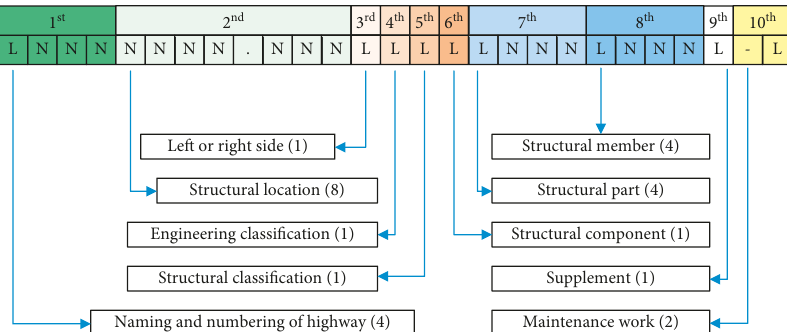
Figure 4: The third classification of EBS coding of a standard structure. Top row 2nd–10th districts are labelled according to letter or number. L refers to abbreviation of “letter” (from A to Z). N refers to abbreviation of “number” (from 0 to 9). The description of breakdown of structure components: structural location, left or right side, engineering classification, and characteristics pertaining to structures.